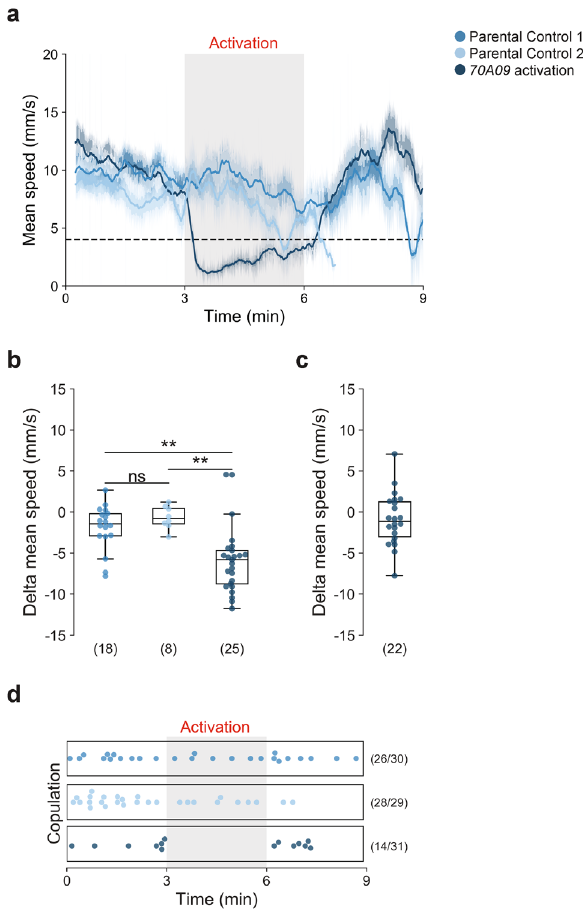
Figure 6. Activation of 70A09-GAL4 brain neurons drastically reduces female speed. ( a ) Female mean speed calculated by rolling average for 15 s with Standard Error of the Mean represented. Genotypes: w-; otd- nls:FLPo/ + ; UAS > STOP > Chrimson.mVenus (Parental Control 1), w-; + ; 70A09-GAL4/ + (Parental Control 2) and w-; otd-nls:FLPo/ + ; 70A09-GAL4/UAS > STOP > Chrimson.mVenus (70A09 activation). ( b ) Difference in flies mean speed between ( b ) activation-baseline periods for all genotypes and ( c ) lightsOFF-baseline periods for 70A09 activation. ( d ) Copulation of activated and control females with the distribution according to latency to copulation. Number of receptive females out of the total number of females are shown in parenthesis. Statistical analysis was performed with Kruskal–Wallis test ( b ), followed by post hoc pairwise Dunn’s test with Bonferroni correction, Wilcoxon rank-sum test: ns = not significant, **p < 0.01. n values are shown in